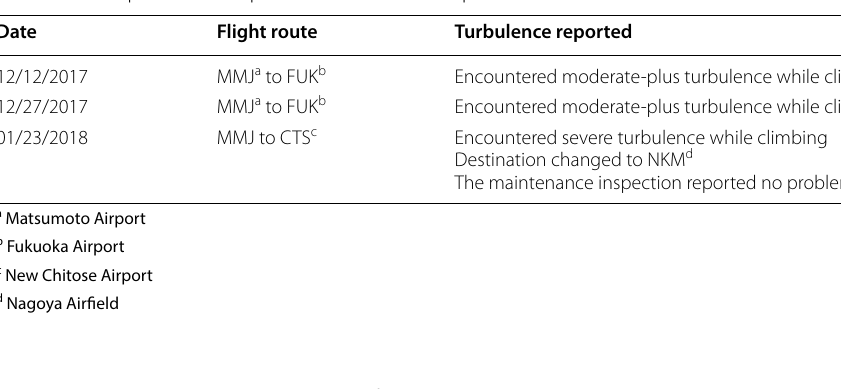
Table 2 Weather conditions at the time of operation on days when turbulence occurs